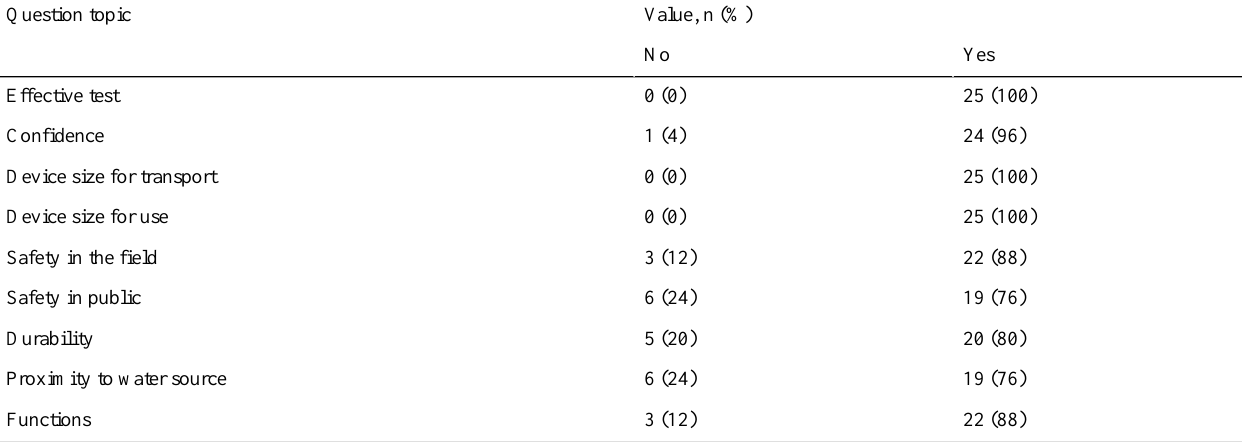
Table 5. Descriptive frequencies of dichotomous